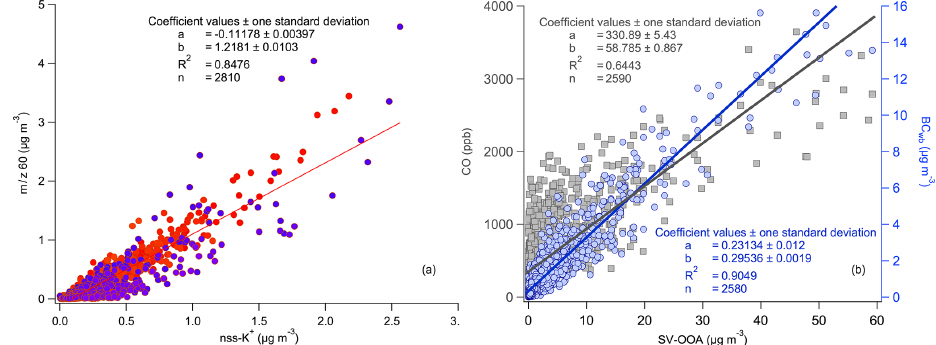
Figure 7. (a) The correlation of m/z 60 with nss-K + for 2013–2014 (red) and 2016–2017 (blue), and (b) the correlation of SV-OOA with CO (grey) and BC (blue) for